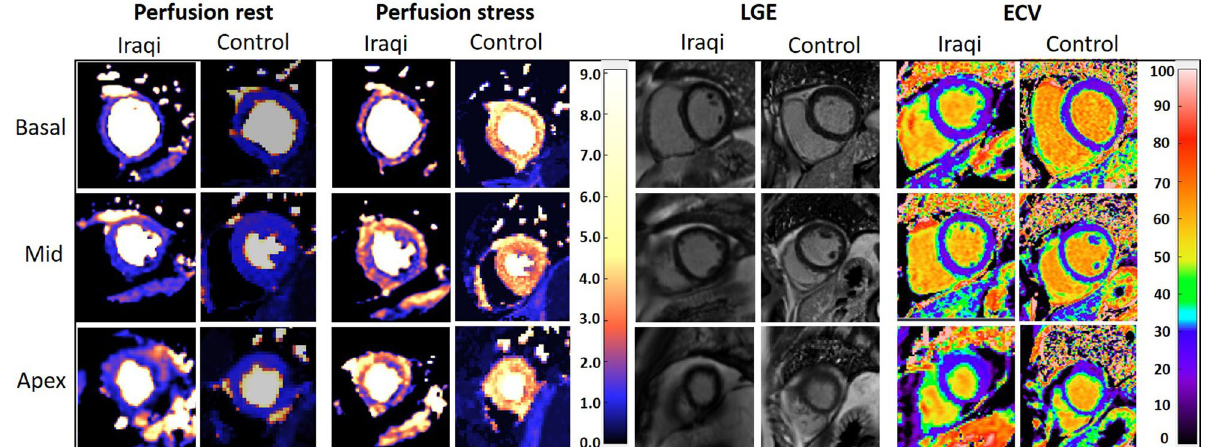
Figure 2. Example of quantitative first pass perfusion at rest and during adenosine stress, late gadolinium enhancement (LGE) and extracellular volume (ECV) CMR images from one Iraqi and one Swedish participant. Note the perfusion defect in the Iraqi subject at stress. No corresponding LGE or increased ECV is